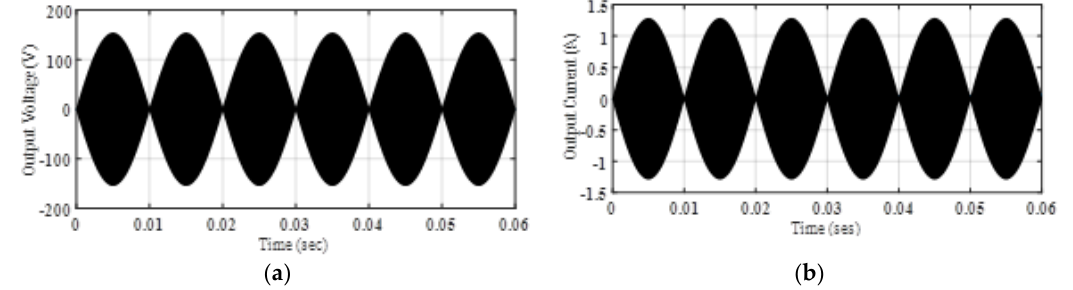
Figure 6. Simulation waveforms of ( a ) output voltage and ( b ) output current.